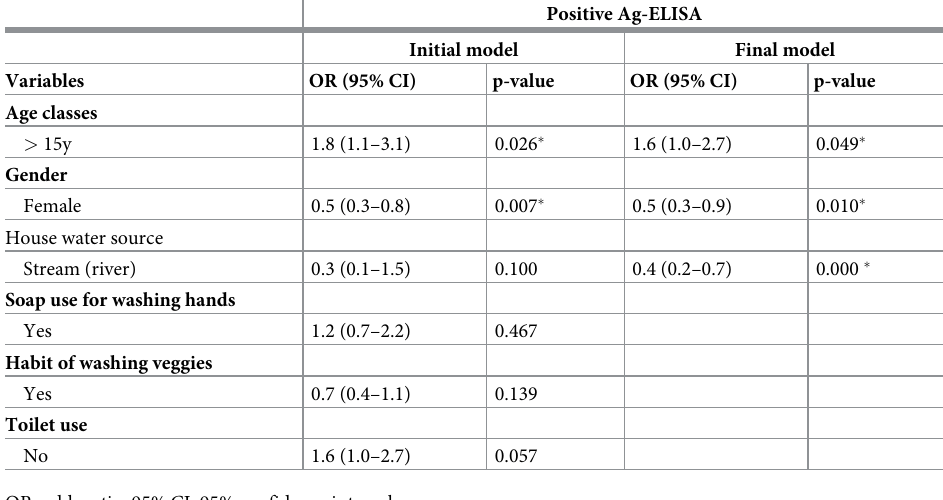
Table 6. Multivariable analysis between risk factors and T . solium infections (positive